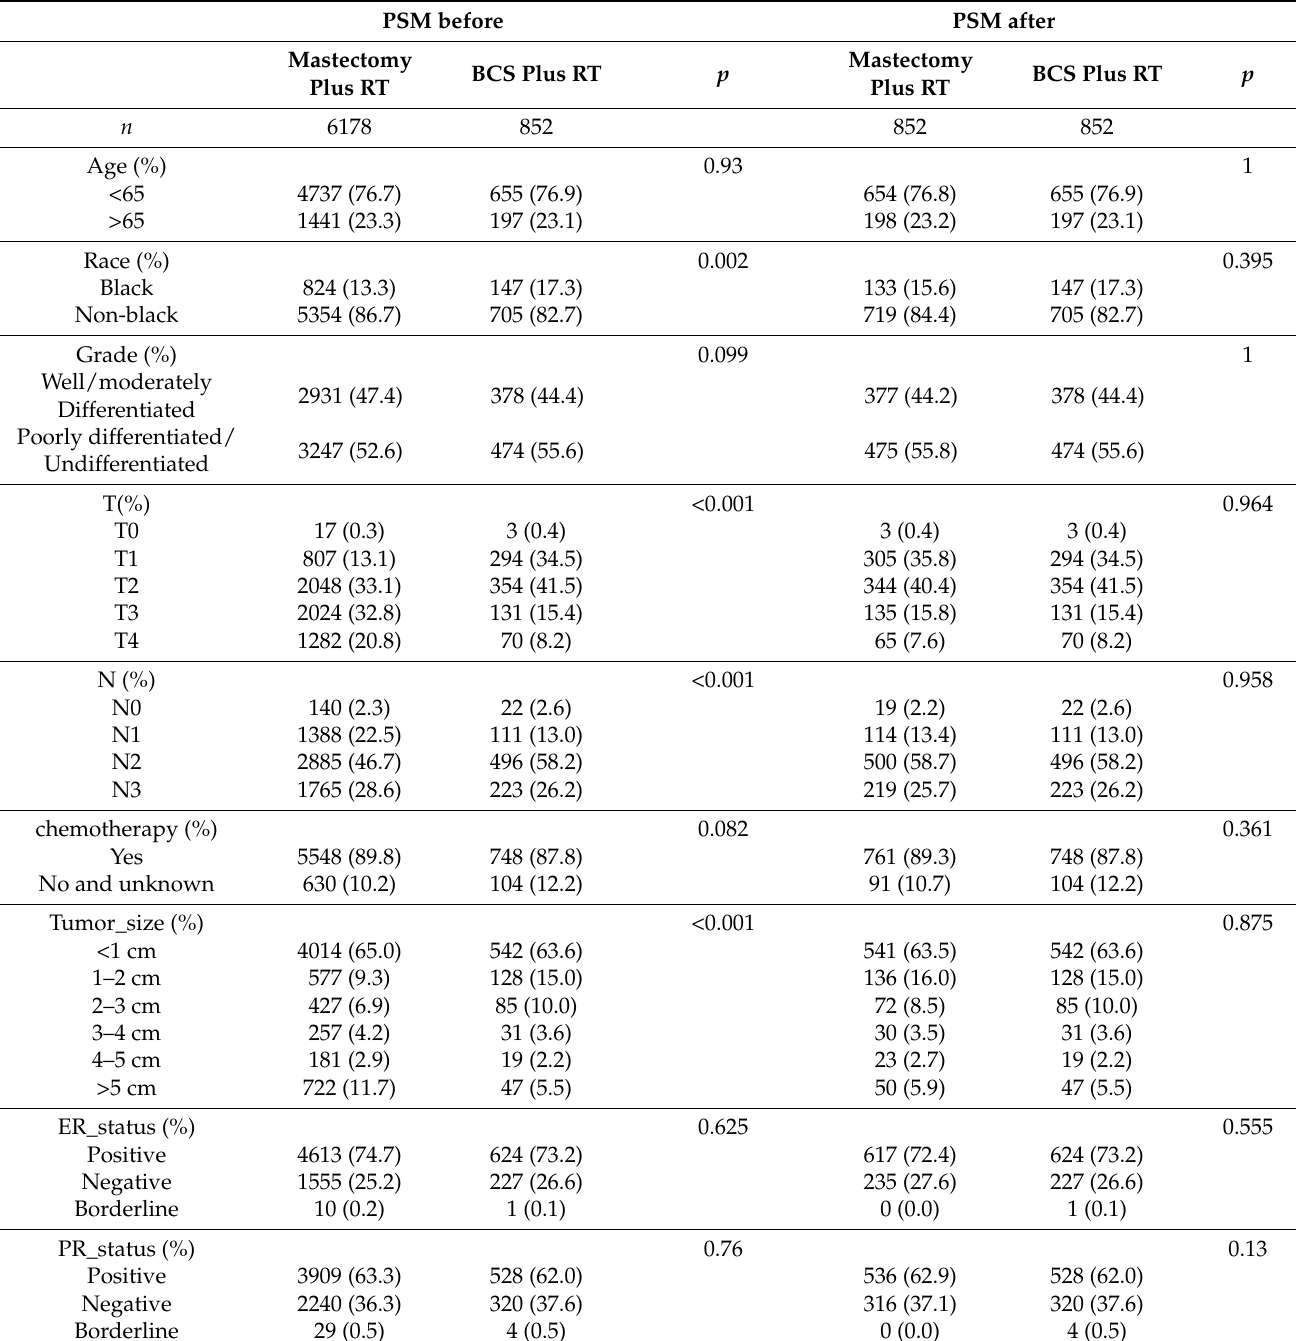
Table 3. Clinical characteristics of patients for stage III before and after propensity score matching